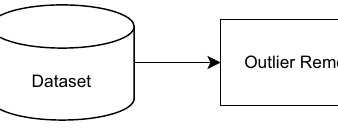
Figure 1. Data Analysis Flow.